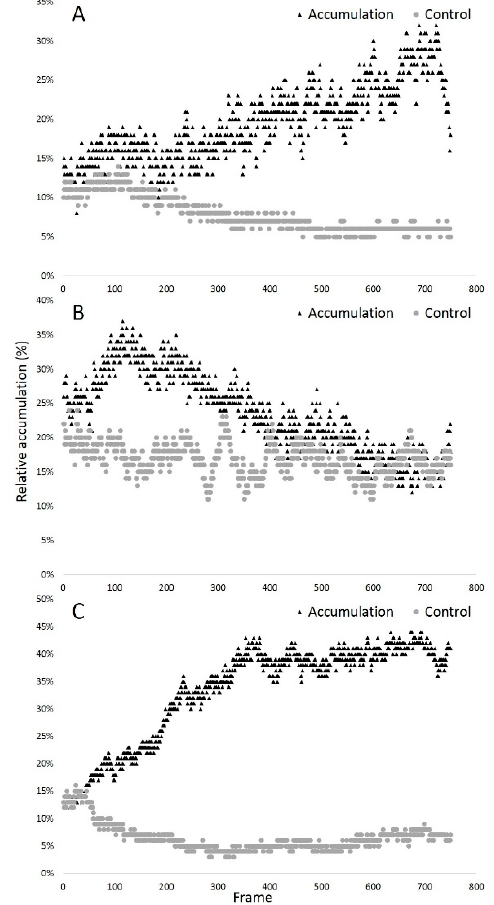
Figure 2. Relative accumulation changes shown by the Chemotactic Sperm Accumulation Module, assessed through individual frame sequences: ( A ) trout spermatozoa; ( B ) carp spermatozoa; ( C ) sterlet spermatozoa.